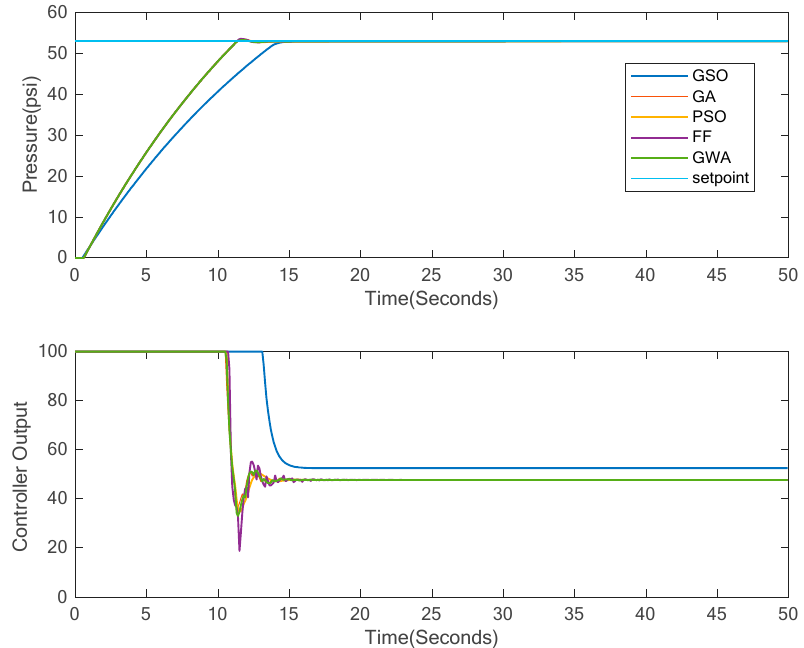
Figure 24. Comparison of the servo response for the pressure control station with optimization algorithms.